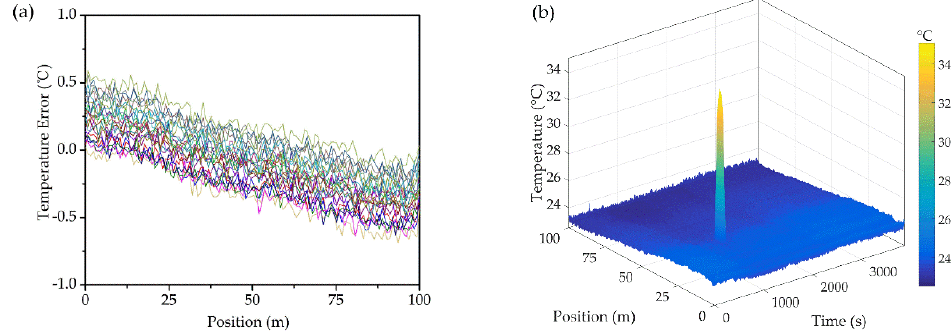
Figure 3. ( a ) Temperature measurement error of the as designed fiber sensor ( b ) Temperature